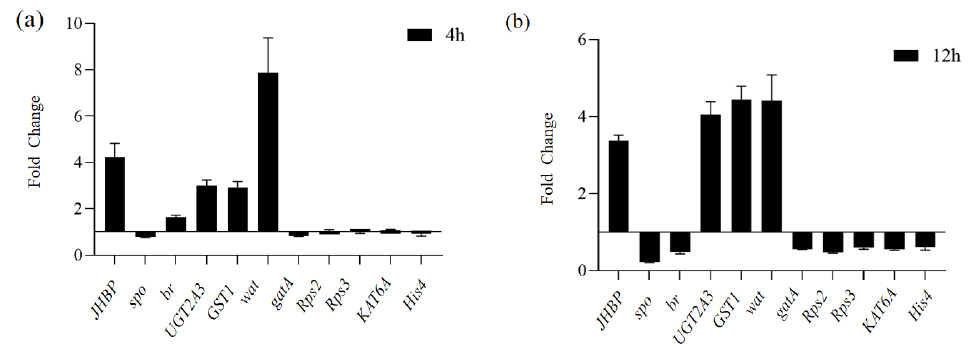
Figure 7. Quantitative real-time PCR analysis of candidate gene expression of ovaries induced by DH after 4 h ( a ) and 12 h ( b ). The vertical axis represents the -fold change of candidate genes in DH group compare with CK group.